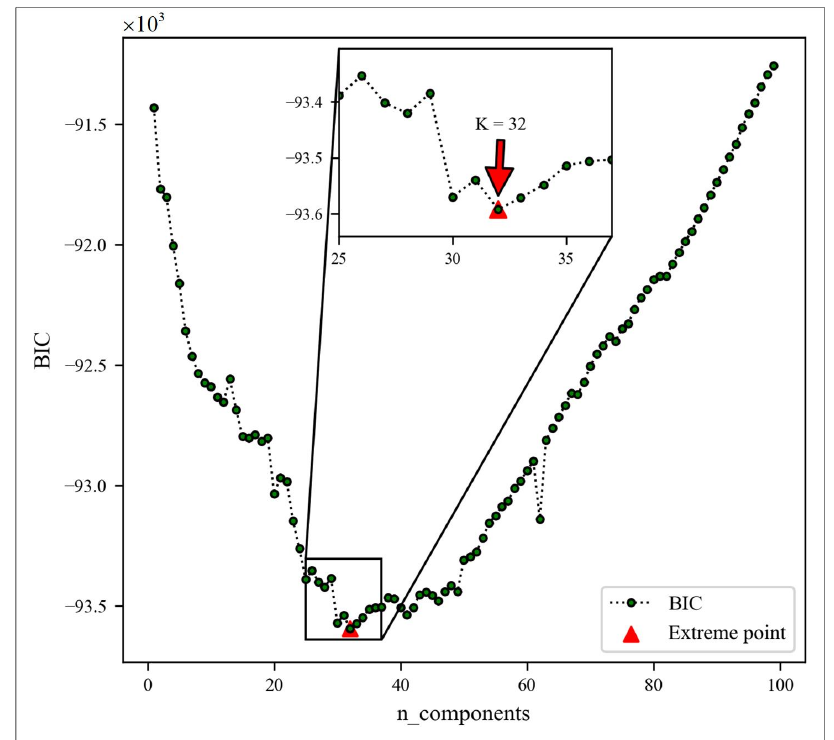
Figure 4. Variation curve between the components and the Bayesian information criterion (BIC) value. The x -axis is the number of Gaussian components, labeled n_components. The y -axis is the BIC value corresponding to different components.